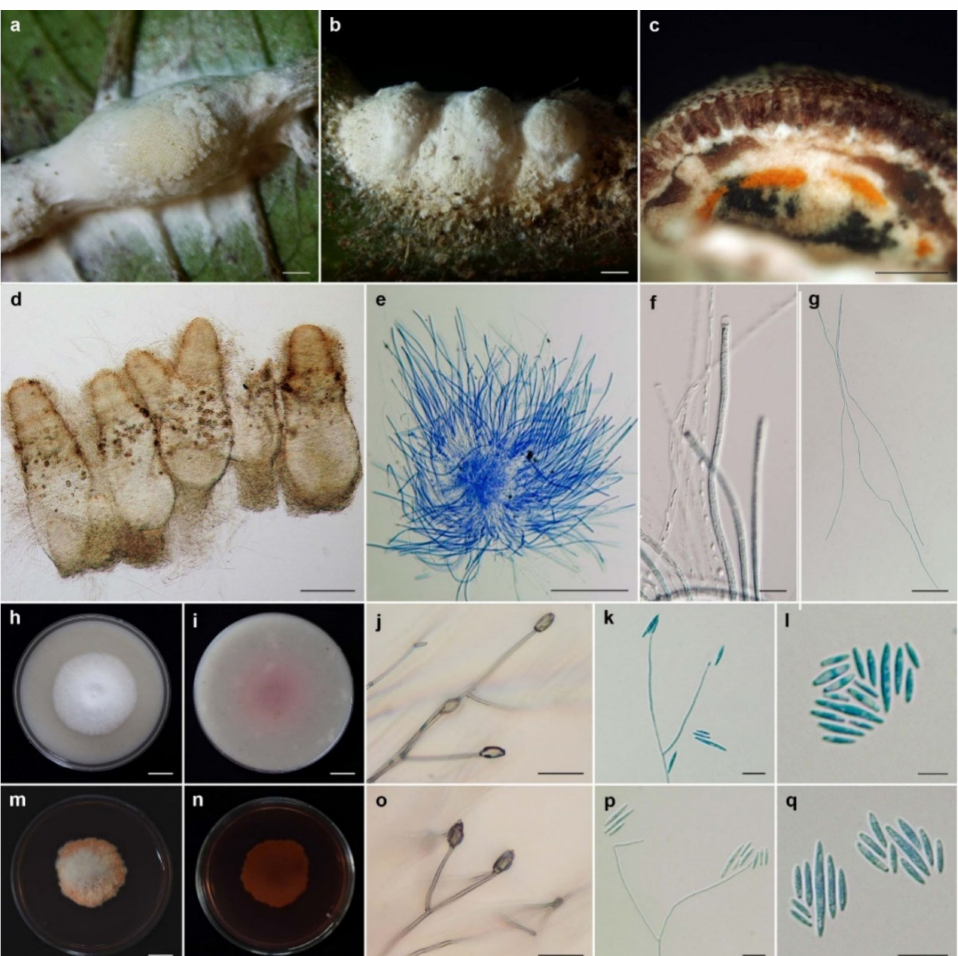
Figure 6. Ascopolyporus purpuratus . ( a , b ) Stromata on living midrib of leaves of dicotyledonous plant (BBH44511); ( c ) cross-section through stroma showing perithecia; ( d ) ovoid perithecia; ( e ) asci; ( f ) asci-caps; ( g ) ascospores; ( h ) colony obverse on OA; ( i ) colony reverse on OA; ( j , k ) phialide apex with conidial head on OA; ( l ) conidia on OA; ( m ) colony obverse on PDA; ( n ) colony reverse on PDA; ( o , p ) phialide apex with conidial head on PDA; ( q ) conidia on PDA. Scale bars: ( h , i , m , n ) = 10 mm; ( a , b , c ) = 1 mm; ( d , e ) = 100 µ m; ( g , j , o ) = 20 µ m; ( f , k , l , p , q ) = 10 µ m. MycoBank : MB